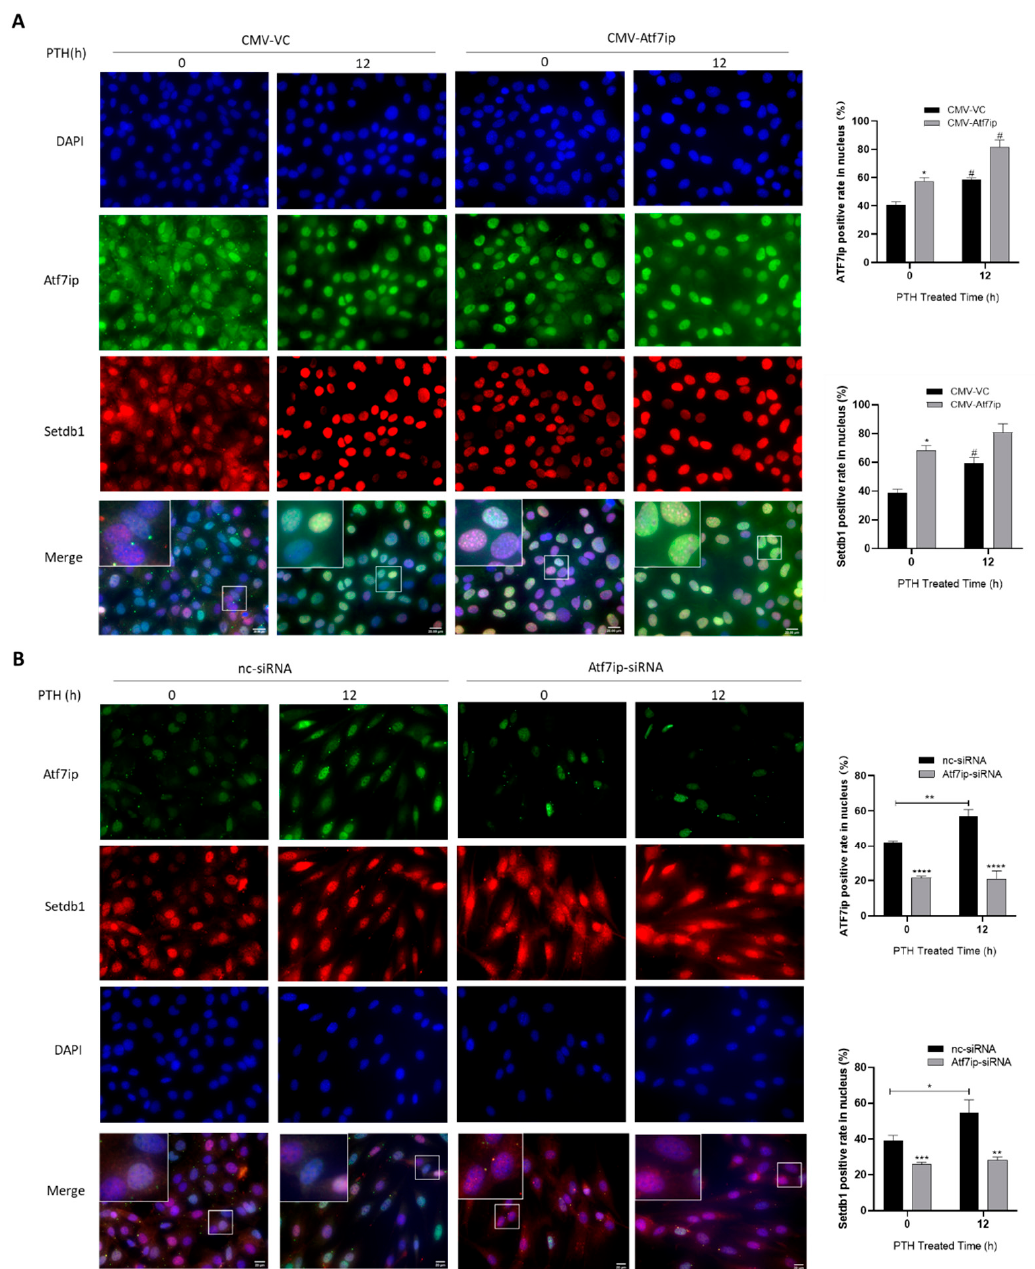
Figure 5. Expression of Atf7ip influences the nucleus localization of Setdb1 in MC3T3-E1. MC3T3- E1 cells were first transfected with CMV-Atf7ip ( A ) or Atf7ip-siRNA ( B ) and their respective controls, and were then treated with or without 500 ng/mL PTH for 12 h. The localization of Atf7ip (green) and Setdb1 (red) was examined by immunofluorescence staining. The nucleus was verified by DAPI (blue). Representative images and high magnification for representative images are shown. Scale bar, 20 µ m. Selected sections magnified 10-fold. The cells with nucleus localization of Atf7ip or Setdb1 were calculated by Image J, n = 4. The experiments were repeated at least three times. Data are expressed as mean ± SD. The significance was measured by one-way ANOVA, * p < 0.05, ** p < 0.01, *** p < 0.001, **** p < 0.0001, Atf7ip overexpression or interference vs. vector control or nc-siRNA group; # p < 0.05, PTH group vs. saline